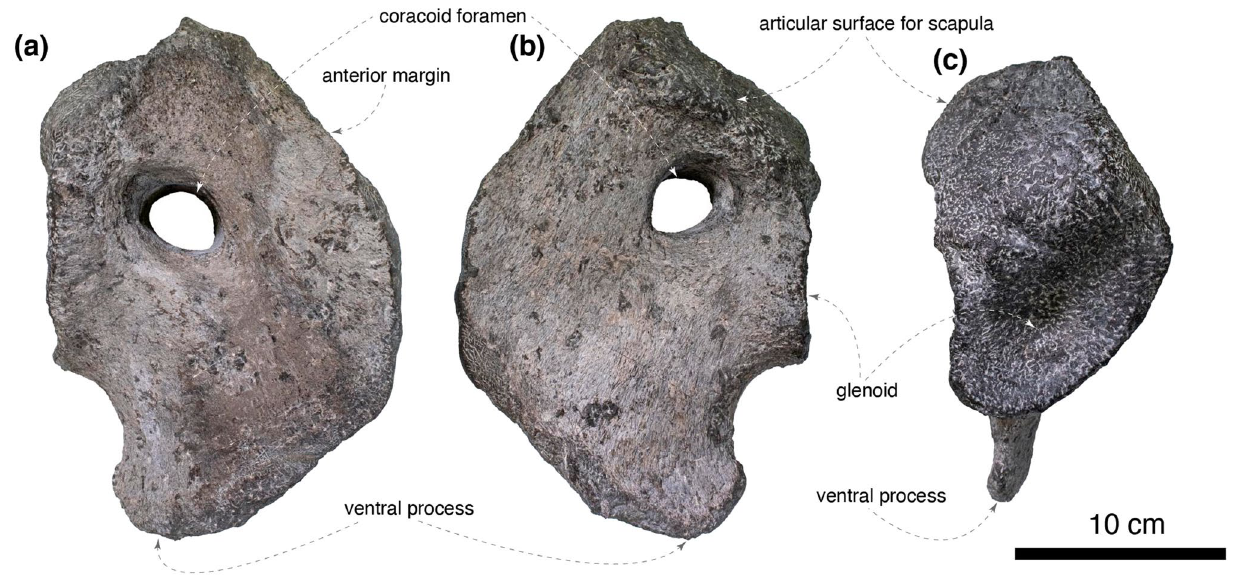
Figure 6. The right coracoid of Yamatosaurus izanagii gen. et sp. nov. in lateral ( a ), medial ( b ), and proximal ( c )